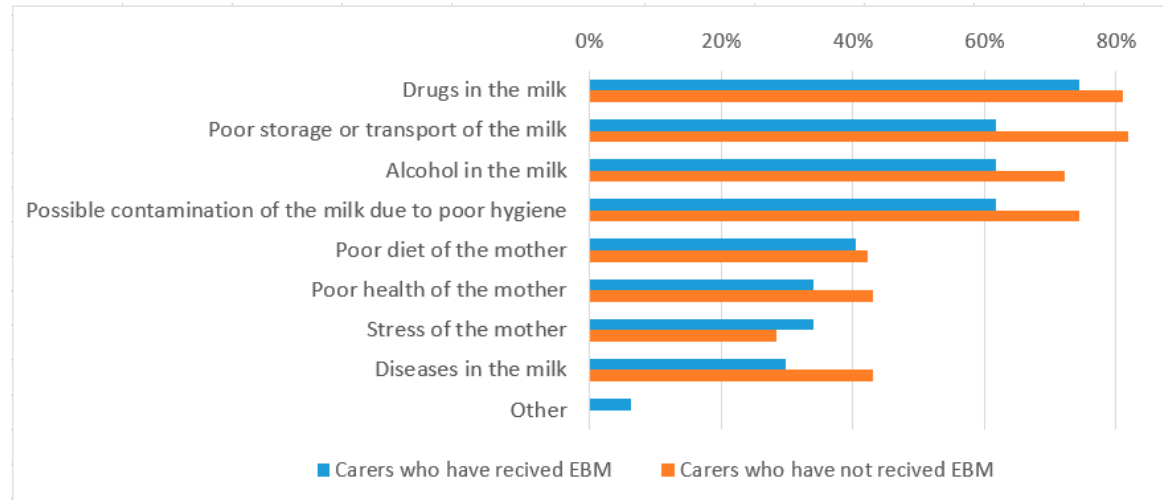
Figure 1. Percentage of carers concerned about the safety of consuming supplied breastmilk.